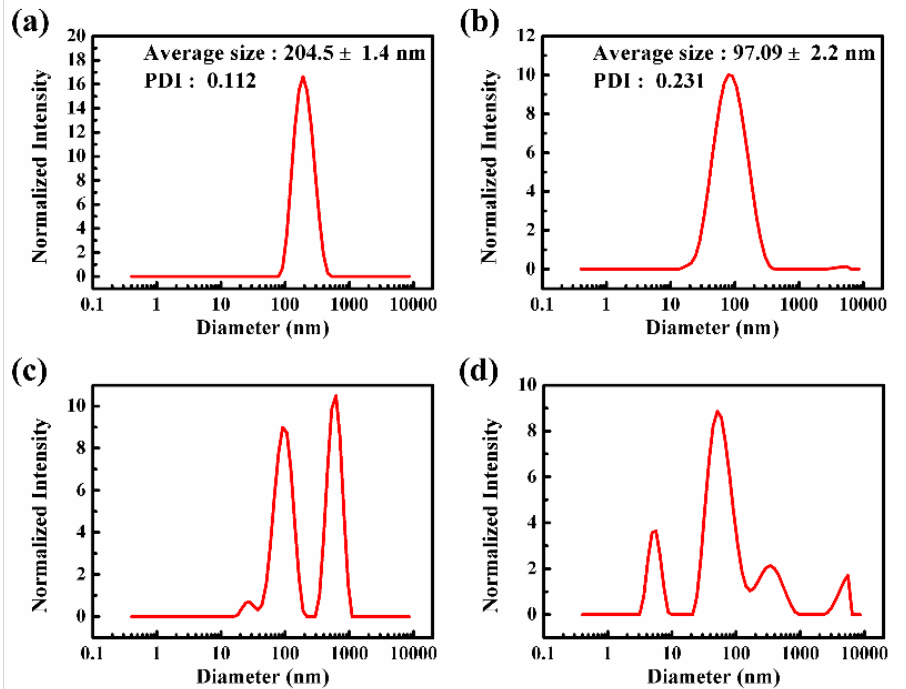
Figure 5. Size distributions of P 1 ( a ), and P 2 ( b ) micelles in HEPES (10 mM, pH 7.4) and P 1 ( c ), and P 2 ( d ) micelles in response to proteinase K (6 U/mL) in HEPES (pH 7.4, 10 mM) at 37 °C for 12 h at a polymer concentration of 0.5 mg/mL. Table 3. Summary of the mean sizes and polydispersity indexes (PDIs) determined by DLS in water and 10% FBS at a polymer concentration of 0.5 mg/mL, as well as the drug-loading content (DLC) and encapsulation efficiency (EE) of these five theranostic unimolecular drug-loaded